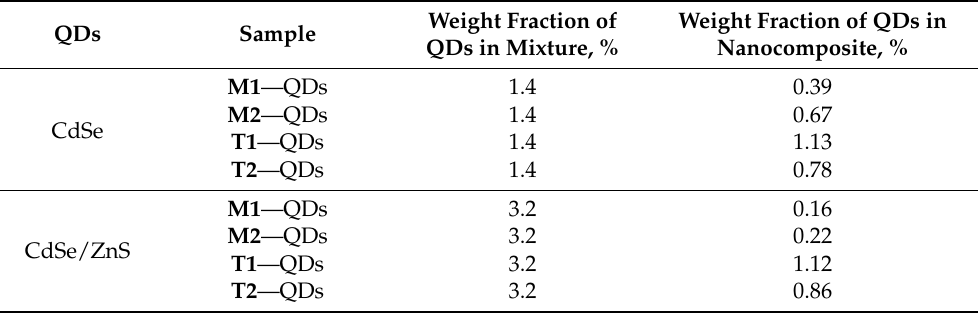
Table 1. The content of QDs in nanocomposites with monochelic PMMA ( M1 and M2 ) and telechelic PMMA ( T1 and T2 ). Weight Fraction of Weight Fraction of QDs in QDs Sample QDs in Mixture, % Nanocomposite, % M1 —QDs 1.4 0.39 M2 —QDs 1.4 0.67 CdSe 0.78